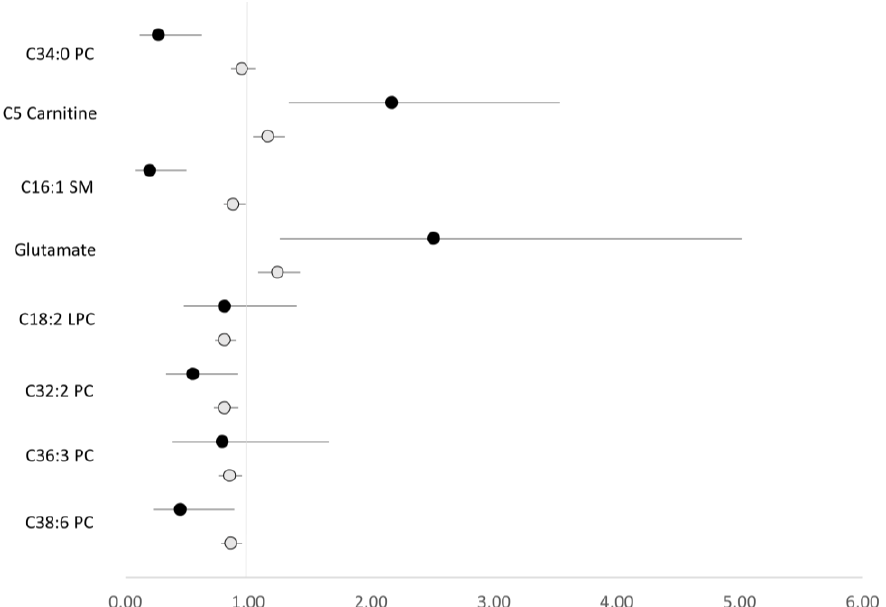
Figure 1. Odds ratios and 95% confidence intervals for RCC per 1 standard deviation (natural log scale) increment in metabolite level, comparing results from PLCO and Guida et al. [24]. Black-filled circles correspond to the PLCO, and gray-filled circles correspond to Guida et al. For reference, the metabolite name abbreviations used above correspond to the abbreviations of PC ae C34:0, isovalerylcarnitine (C5), SM C16:1, glutamate, lysoPC a C18:2, PC ae C32:2, PC ae C36:3, PC ae 38:6 in Guida et al. For the first three metabolites, Guida et al. results are based on crude models in the supplement (only these results were available), while the remainder are based on BMI-adjusted models in the main results.